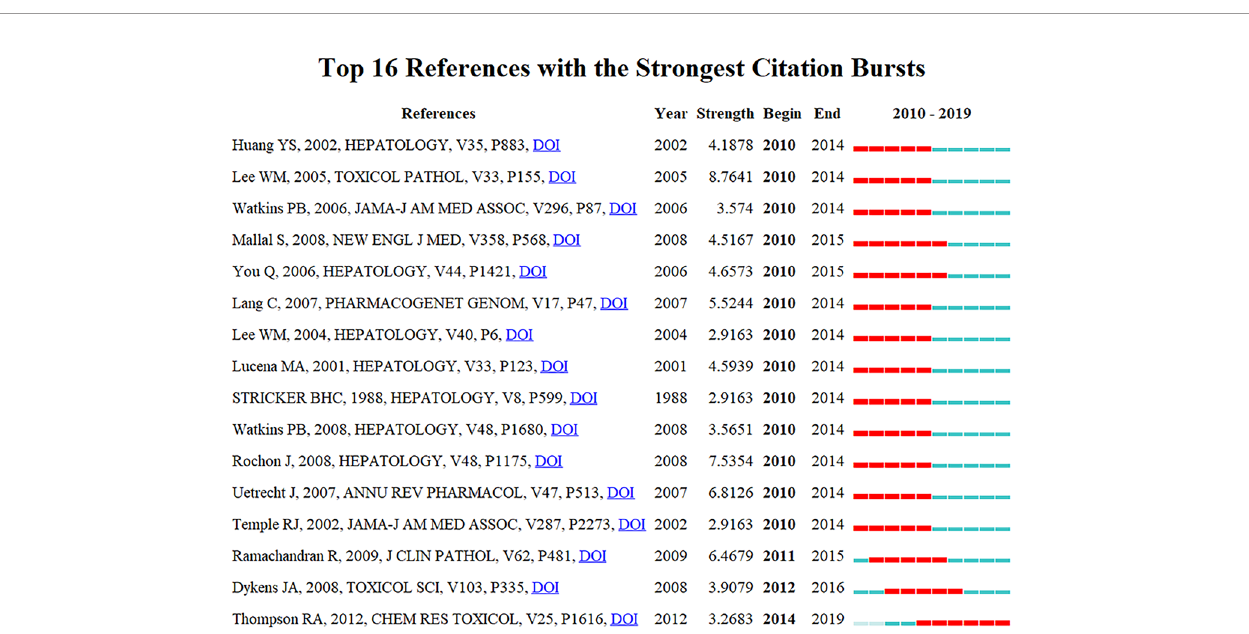
FIGURE 7 | The network map of co-citation references for drug-induced liver injury (DILI) research (T = 125).